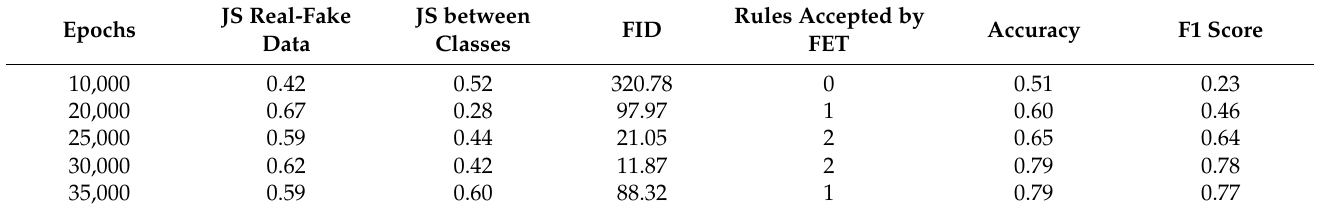
Table 1. Obtained metric results for data augmentation.